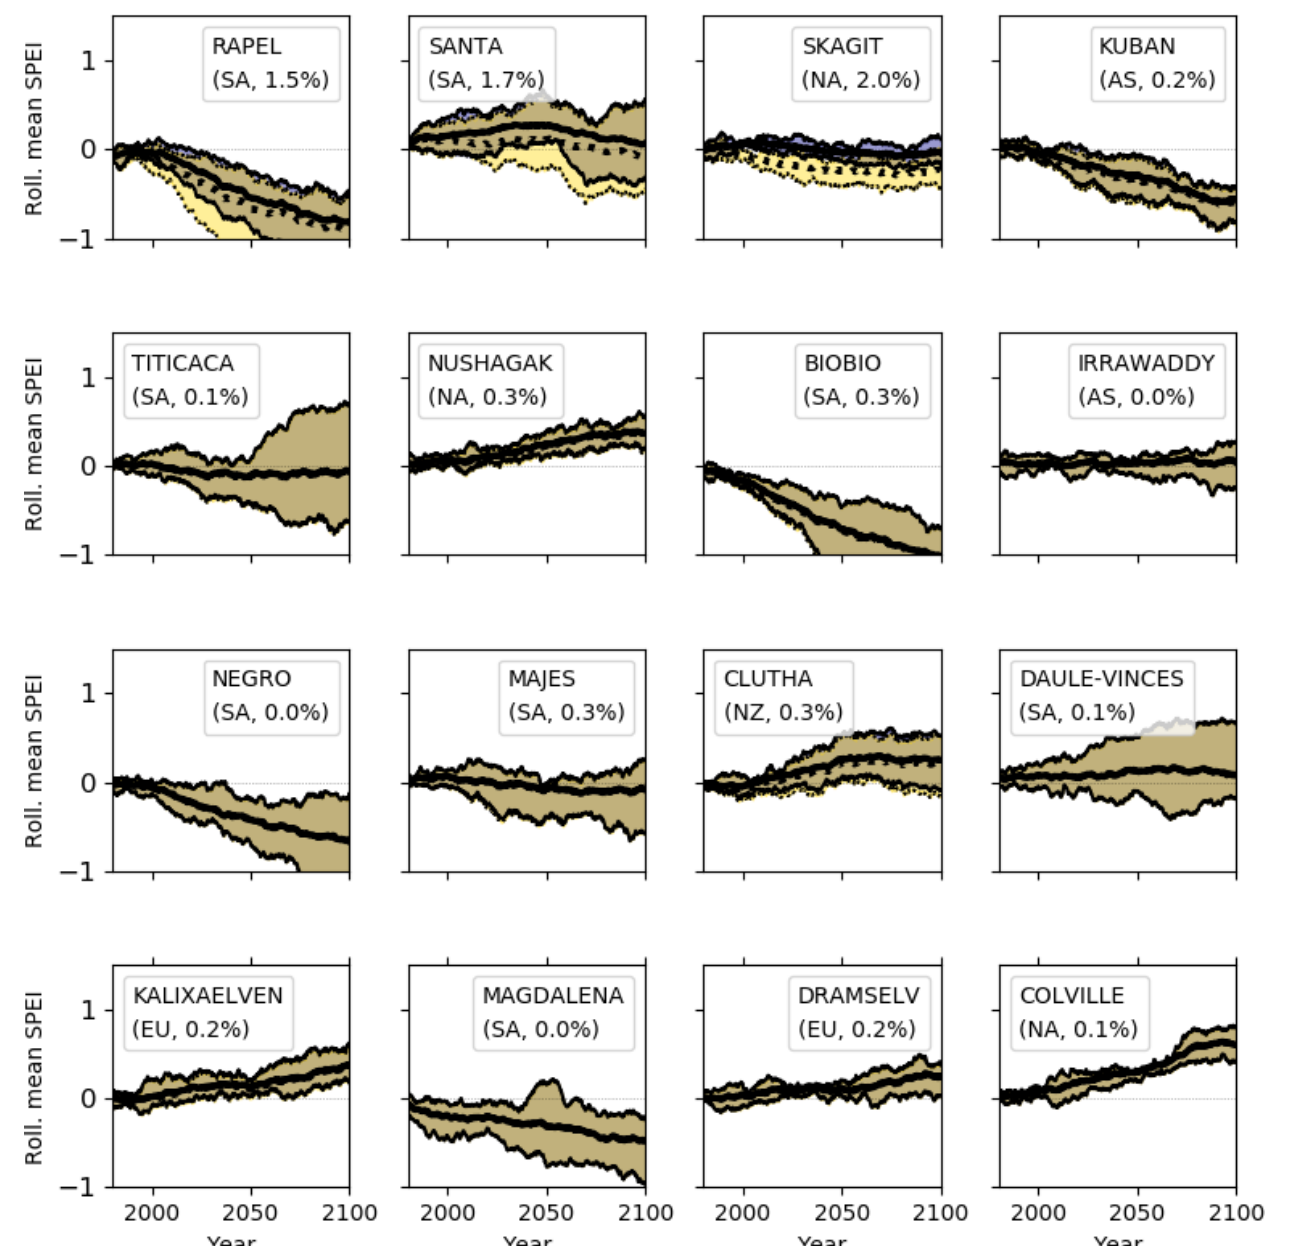
Figure A1. 30-year running ensemble mean (lines) and interquartile range (shaded region) of SPEI 3mo with glacial runoff (blue shading) and without (yellow shading), for the RCP 4.5 scenario, similar to the main text Fig. 1. Basins are presented in descending order of total glacier area. Unlike Fig. 1, all panels here share a common y -axis scale for ease of comparison. As a result, smaller-magnitude shifts are less apparent here. Basins are labeled by name, regional abbreviation, and percent glacial cover. Abbreviations are ‘AS’ for Asia, ‘EU’ for Europe, ‘NA’ for North America, ‘NZ’ for New Zealand, and ‘SA’ for South America.